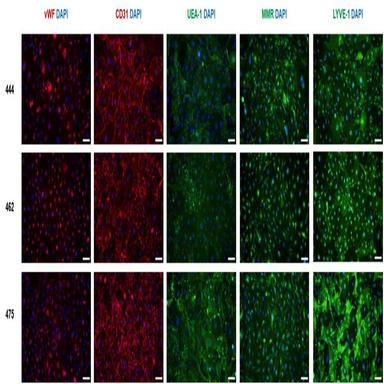
upcyte® LSECs maintain expression of common endothelial and LSEC-associated markers. upcyte® LSECs were fixed and permeabilized followed by antibody staining and analysis by fluorescence microscopy. UEA-1 staining was performed on living cells. Overlay images are shown for von Willebrand factor (vWF, red), CD31 (red), FITC-conjugated Ulex europaeus agglutinin I binding (UEA-1, green), macrophage mannose receptor (MMR, green) and lymphatic vessel endothelial hyaluronan receptor 1 (LYVE-1, green). Nuclei were